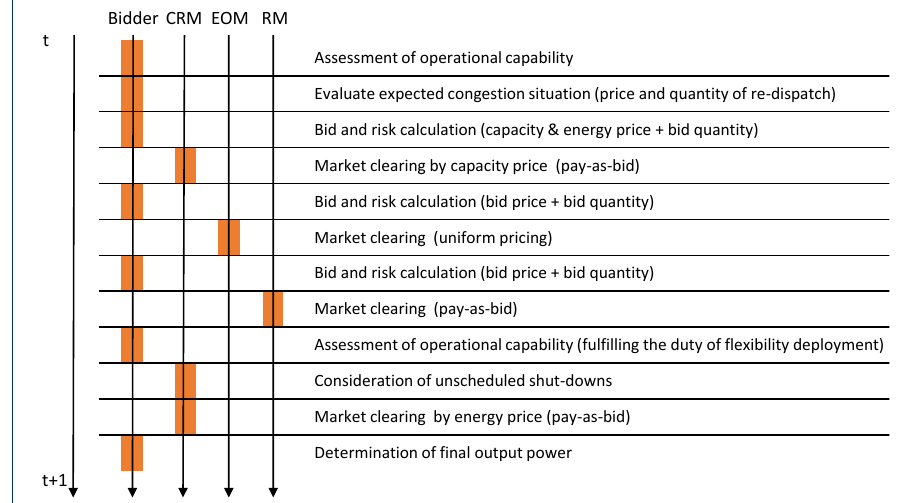
Figure 1 Sequence of actions in the simulation run showing succession of bidding on the di(cid:11)erent market platforms, control reserve market (CRM), energy-only market (EOM), redispatch market (RM). The left access represents the timeline, where t is a time